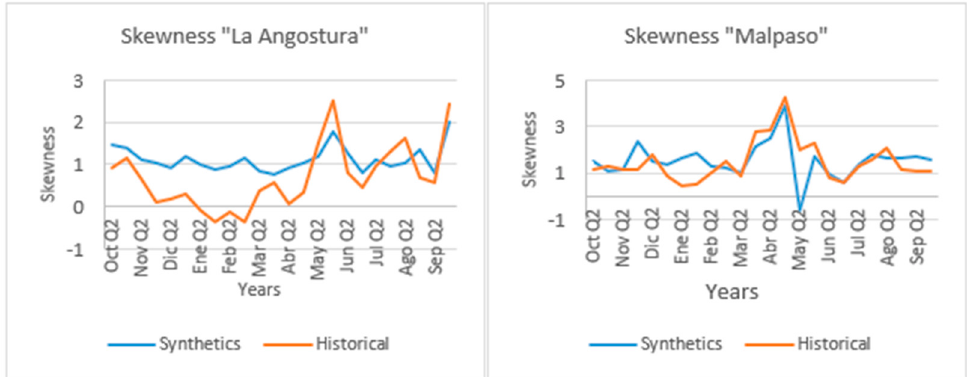
Figure 6. Comparison of the skewness coefficient and average of the 10 synthetic series vs. historical series of La Angostura and Malpaso Dams.